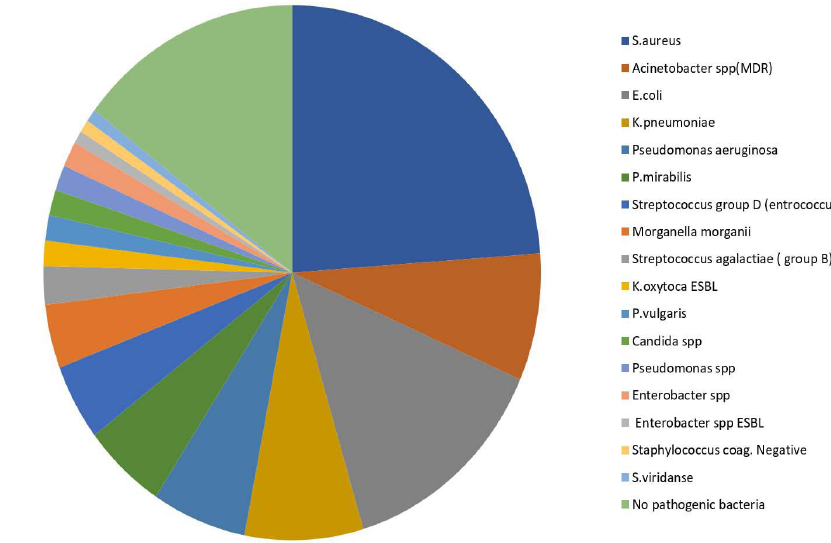
Fig. 7. Diabetic foot ulcer infections